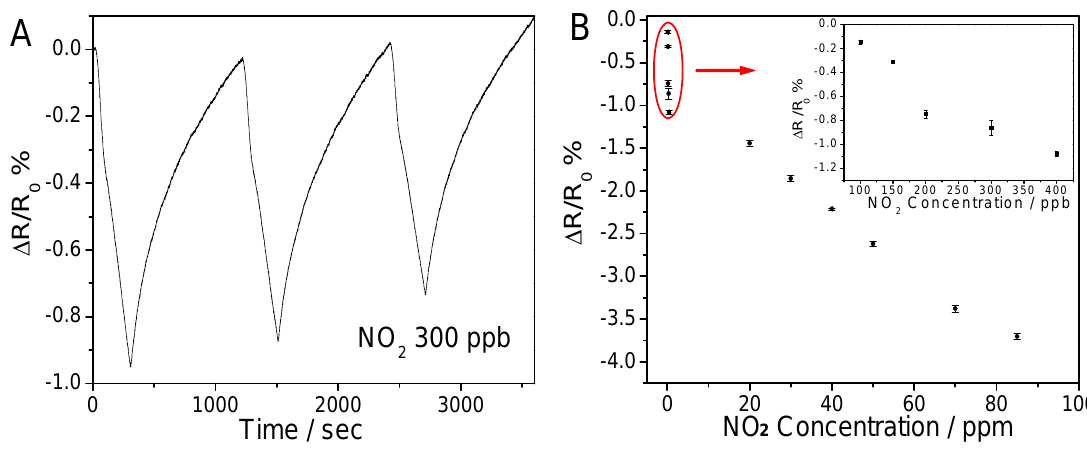
-PEDOT nanocables upon periodic exposure 2 at an applied DC bias of 0.1 V and room 3